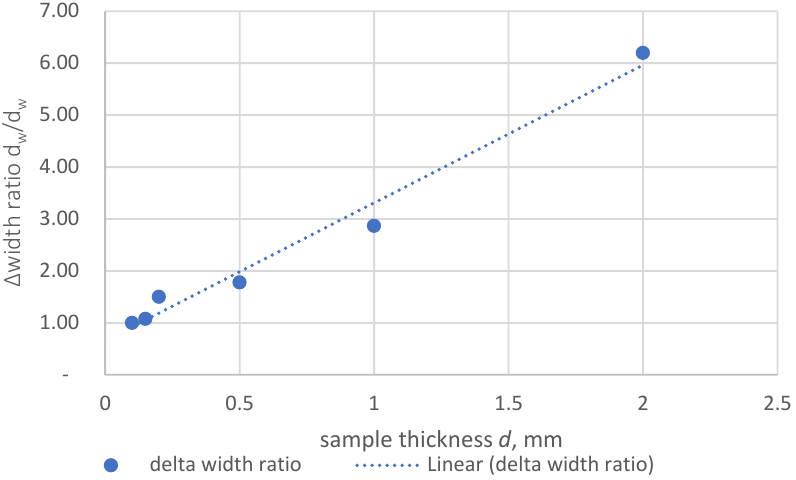
Figure 14. Impact of sample thickness on the equivalent charge layer d w ; pulser width t w = 5 ns, t r = 1 ns, PVDF sensor d s = 9 µm, LDPE sample.